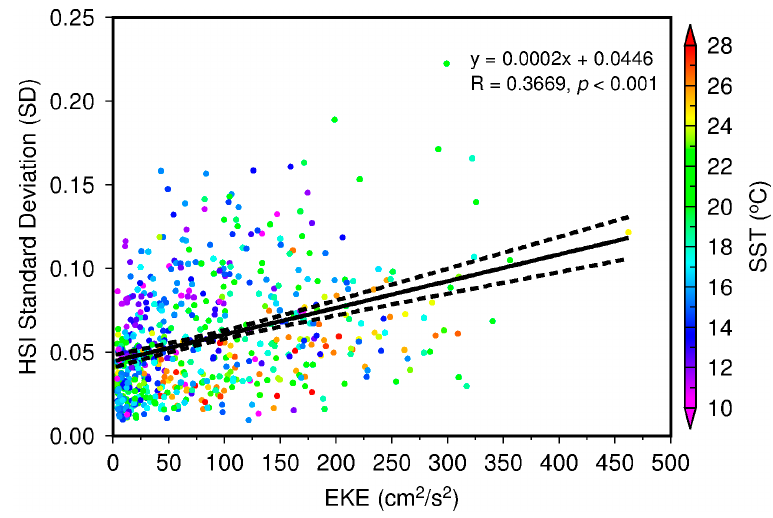
Figure 7. Scatterplot of EKE and HSI standard deviations (SD) extracted from squid fishing locations, from January–December. All data points were plotted in circles and color-scaled with SST ( n = 602). The black solid line corresponds to the linear fit and the dotted lines are confidence bounds for the fitted coefficients at a 95% confidence interval.